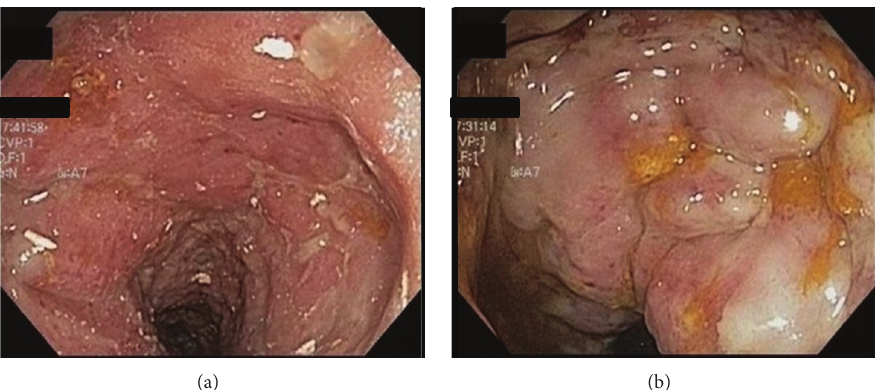
Figure 2: Images from repeat flexible sigmoidoscopy showing (a) erythematous, friable, and ulcerated mucosa in the rectum and (b) edematous and ulcerated mucosa with decreased vascular pattern in the sigmoid colon.